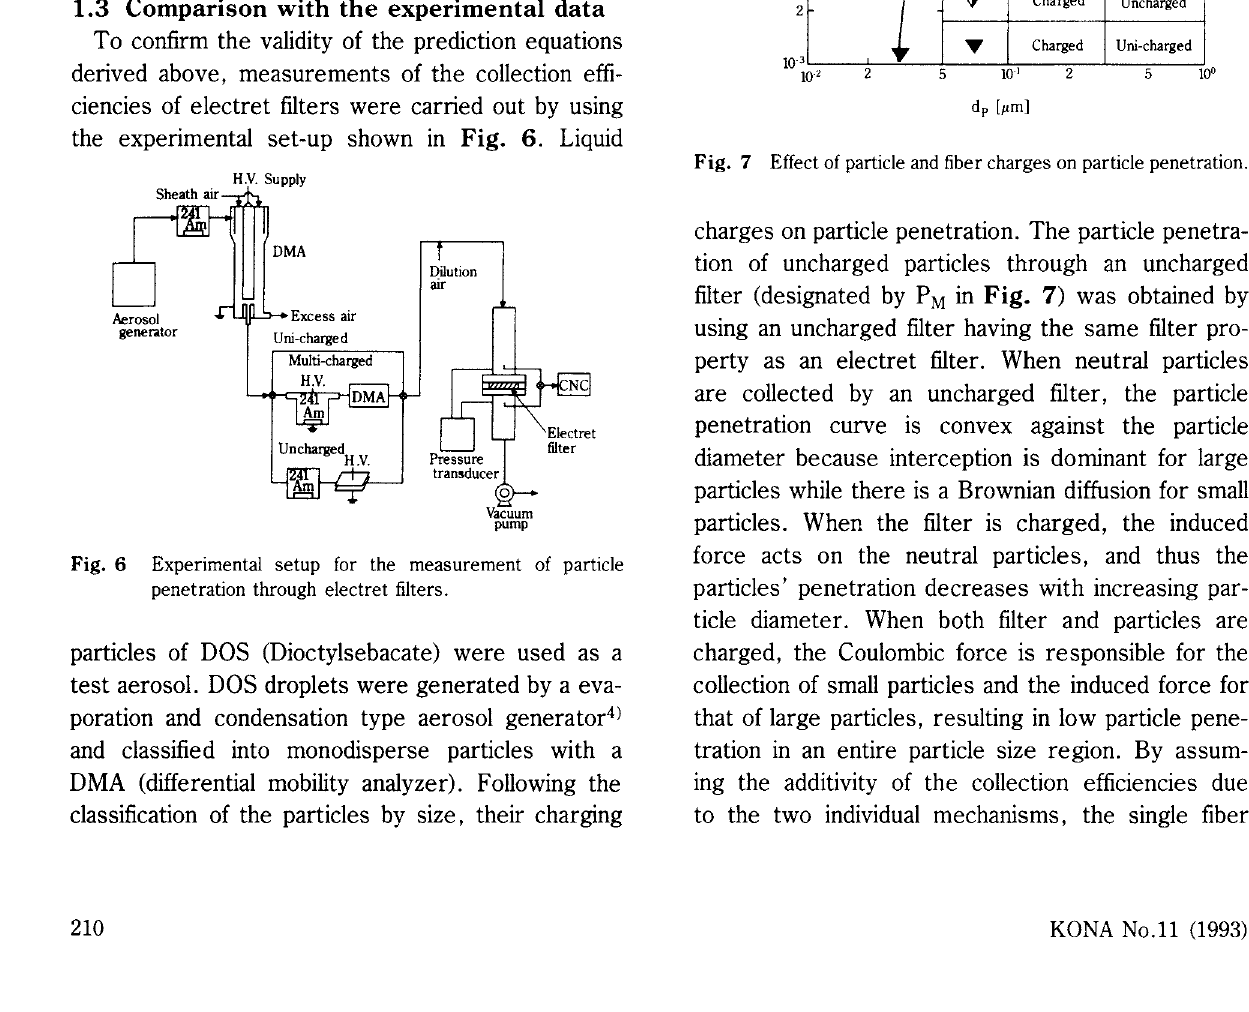
Collection efficiencies of a single electret fiber due to induced force.